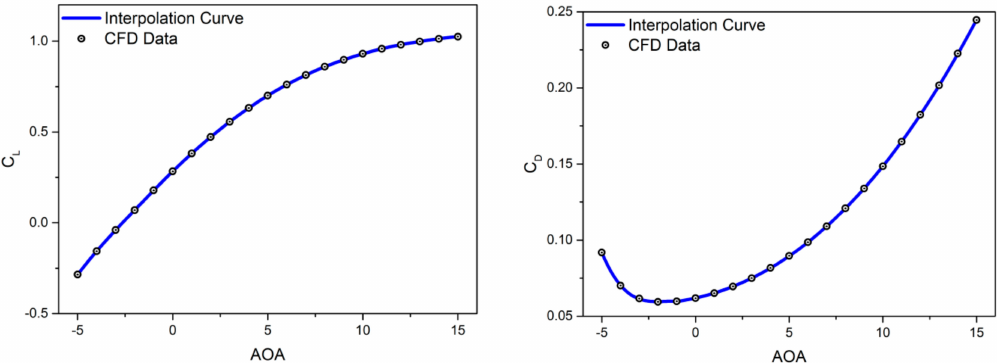
Figure 10. FX63 airfoil performance at Re = 8000.